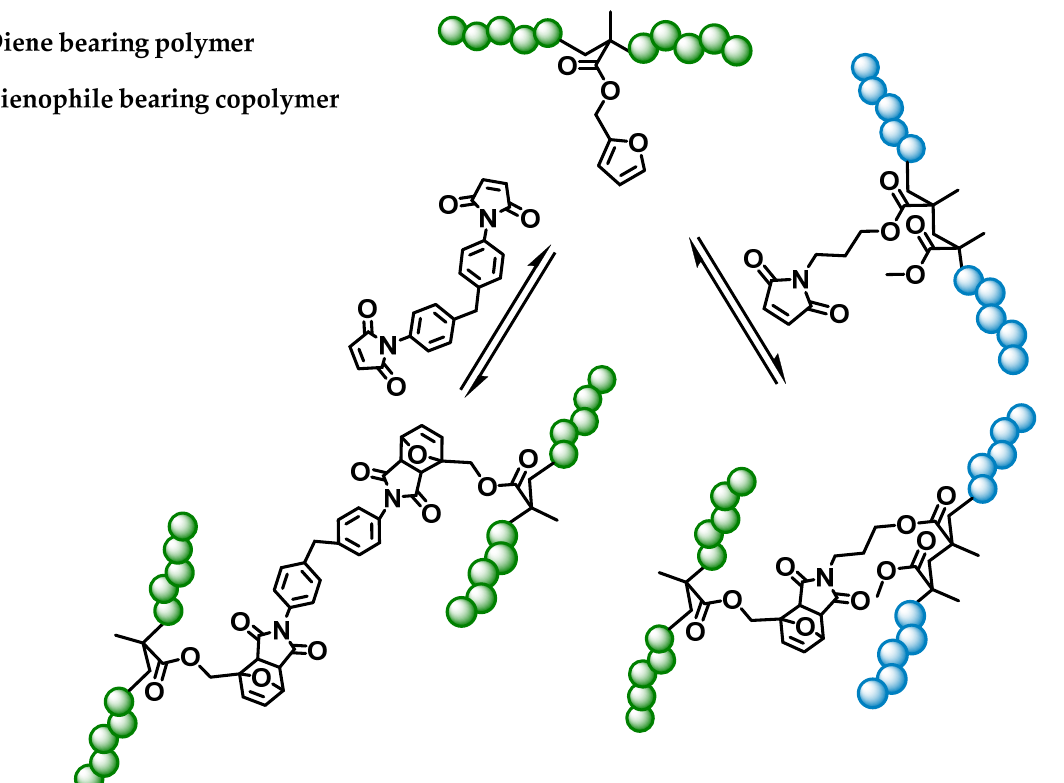
Figure 7. Crosslinking paths via the Diels-Alder reaction of furfuryl and maleimide bearing groups.